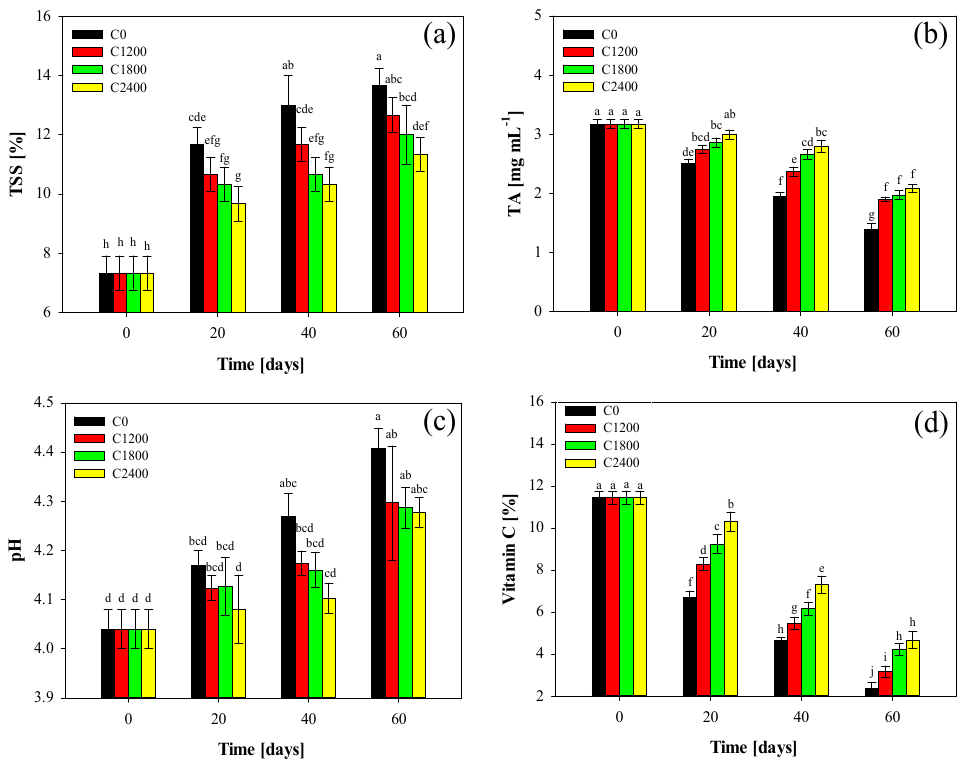
Figure 3. Values of ( a ) total soluble solids (TSS), ( b ) total acidity (TA), ( c ) pH, and ( d ) vitamin C of untreated (control) and coated (CEO concentration = 1200–2400 μ L/L) apple fruits during 60 days of cold storage (4 °C). Different letters above the bars denote significant ( p < 0.01) differences between mean values.